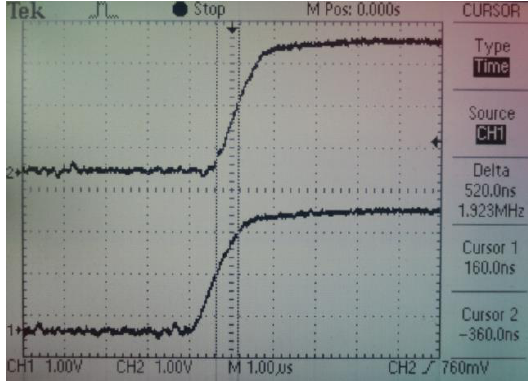
Figure 2. Precision of the cameras PTP-synchronization The precision of the synchronal image capture can be measured via the sync outputs of the cameras. If the frame acquisition begins the IO Pin is set to high and can be measured by an oscilloscope. The result is shown in 2. The delay between the exposures of the cameras is 500-560ns. The handling of the image data, capture and storage, is a further big challenge.